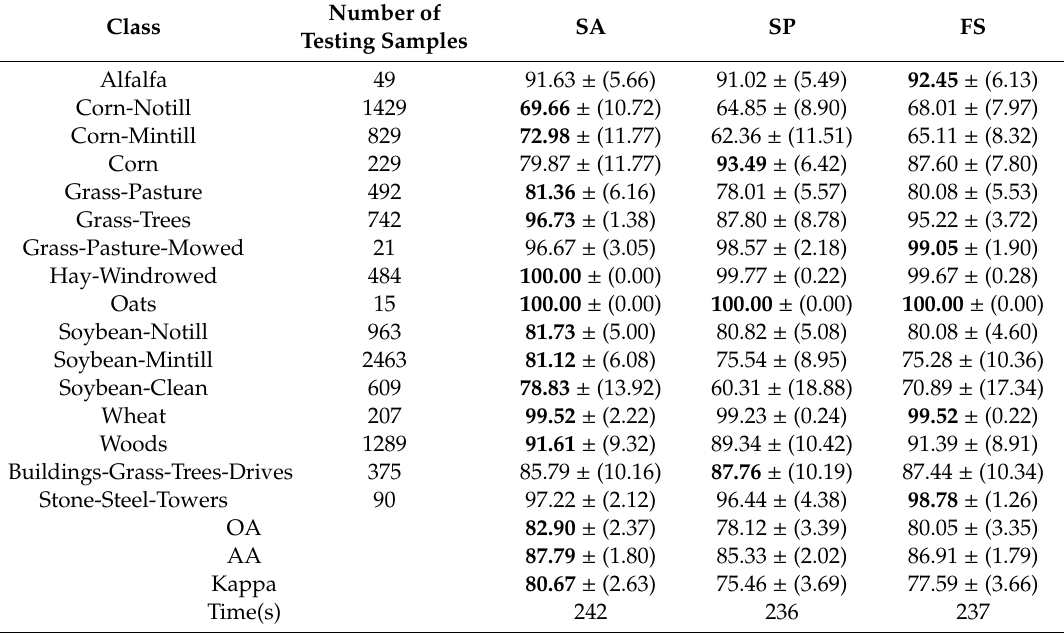
Table 1. Class-specific accuracies (CAs), OAs, average accuracies (AAs), kappa (as a percentage, with the standard deviation in brackets), and running time average statistics obtained with unlabeled samples selected from the SA-, SP-, and FS- based neighborhood for Indian Pines dataset.